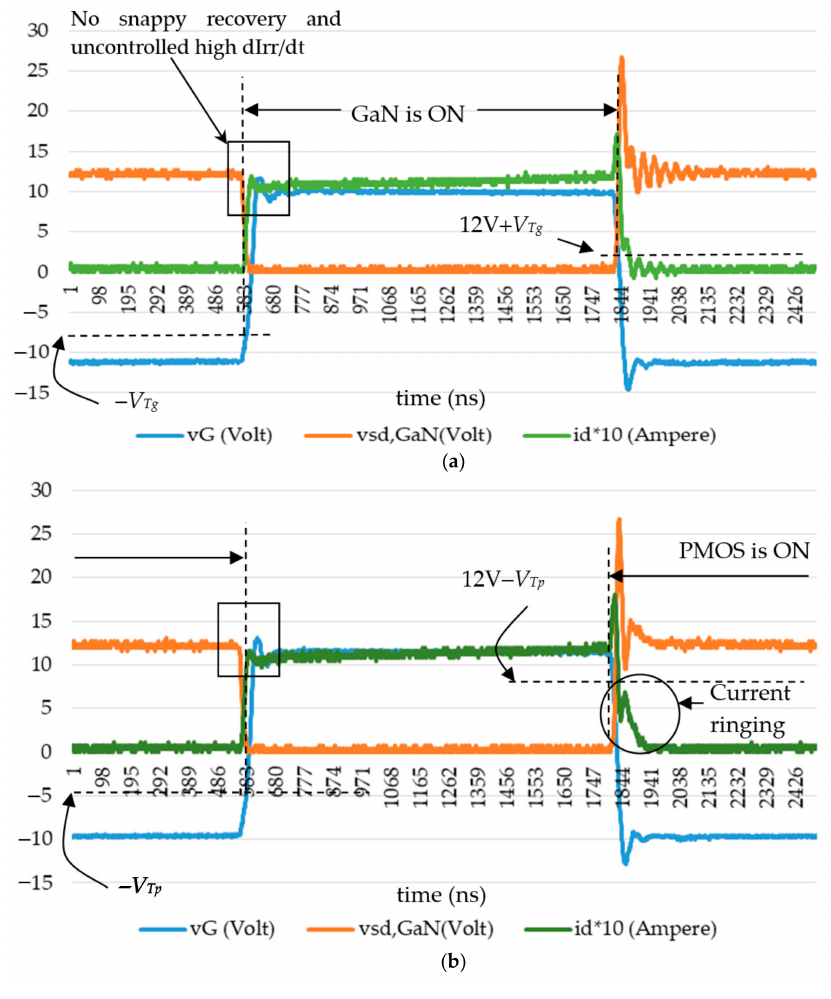
Figure 17. The experimental result for the 12 V to 6 V step down at a switching frequency of 1 MHz with ( a ) V Z = 10 V and ( b ) V Z = 11 V (0.8 ns per tick).